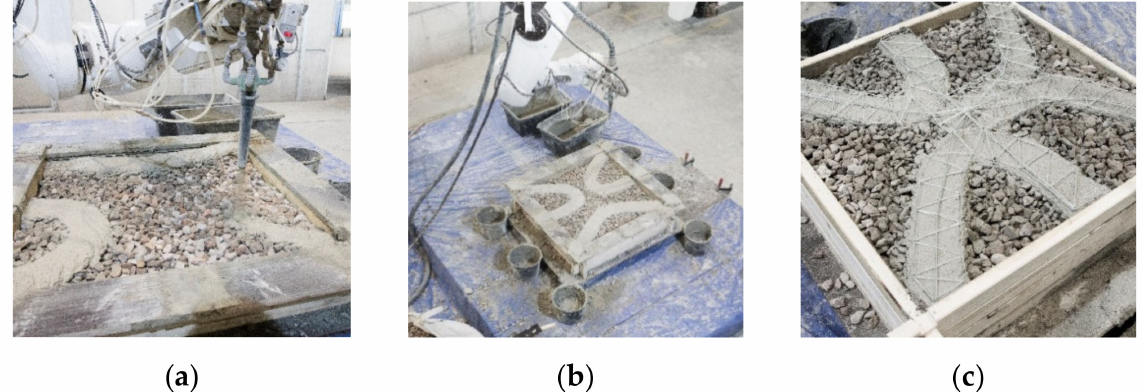
Figure 15. LP3DCP Additive Manufacturing process: ( a ) Close-up of the printing process during which the fine grain concrete is sprayed onto the particle bed; ( b ) formwork with printed path; ( c ) manually placed, prefabricated fiber-